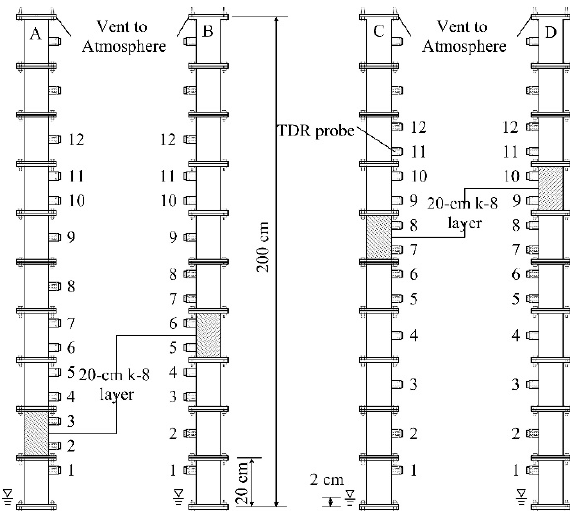
Figure 4. Schematic of the setup of the layered soil